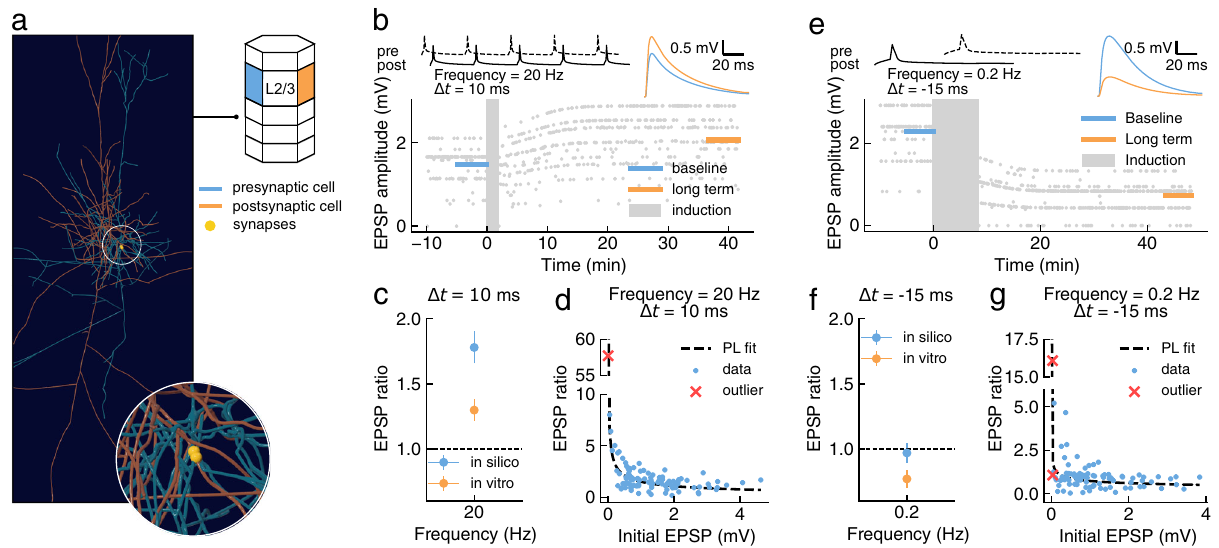
Fig. 4 Testing plasticity model generalization on the L2/3-PC to L2/3-PC connection type. a 3-D rendering of a representative pair of connected layer 2/3 pyramidal cell (L2/3-PC) to L2/3-PC in the in silico model. Inset shows a magni fi ed view of the synapses mediating the connection (yellow spheres). b Evolution over time of simulated EPSP amplitude (bottom) during a typical plasticity induction protocol (top left; one burst shown out of 10). Mean EPSP amplitudes (top right) are shown before (baseline; blue) and after (long term; orange) the induction protocol. c Comparison of in silico and in vitro synaptic changes for pairings at 20 Hz and Δ t = 10ms ( n = 99). Welch ’ s unequal variances two-sided t-test showed a signi fi cant difference between in vitro and in silico data ( p-value = 0.002). Experimental data (in vitro) from Egger et al. 41 . d Change of EPSP ratio after plasticity induction as a function of initial EPSP amplitude. Data fi t by power law (dashed black line; f ( x ) = 1.52 x − 0.49 ). e As in b for a different stimulation protocol (top left; one pairing shown out of 100). f Comparison of in silico and in vitro synaptic changes for pairings at 0.2 Hz and Δ t = − 15 ms ( n = 98). Welch's unequal variances two-sided t-test showed no signi fi cant differences between in vitro and in silico data ( p-value = 0.069). g Change of EPSP ratio after plasticity induction as a function of initial EPSP amplitude. Data fi t by power law (dashed black line; f ( x ) = 0.74 x − 0.26 ). Experimental data (in vitro, panels c , d ) from Egger et al. 41 and (in vitro panels f – g ) from Banerjee et al. 43 . Population data reported as mean±SEM. For the full distribution of in silico experiment outcomes see Supplementary Fig. A.12 (data in panels c , d ) and Supplementary Fig. A.13 (data in panels f , g